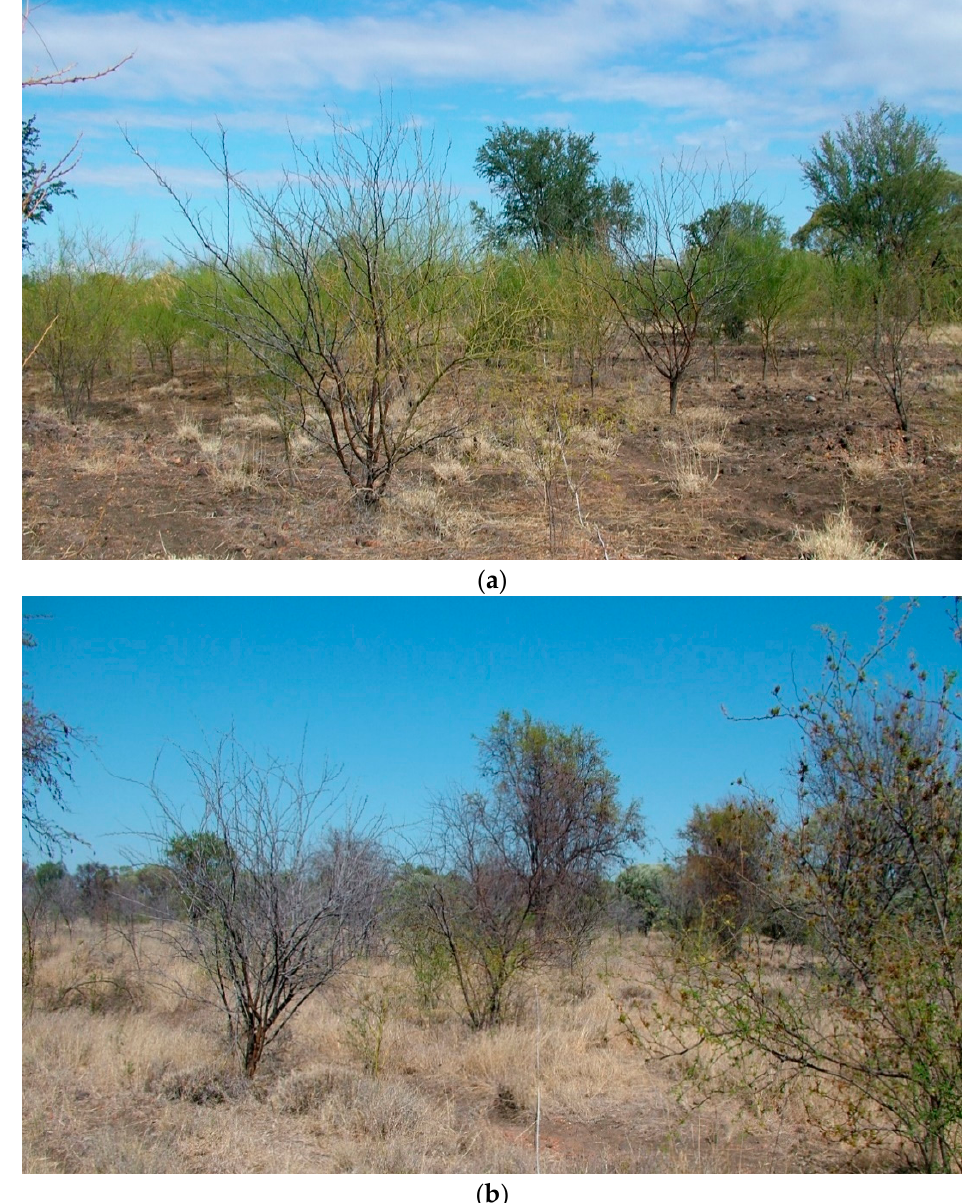
Figure 5. Transect 1 viewed at 0 m (start of transect) at establishment in 2005 ( a ), and final assessment in 2012 ( b ). Note the obvious disappearance of live parkinsonia plants (with light-green foliage) from the background in the second photograph.